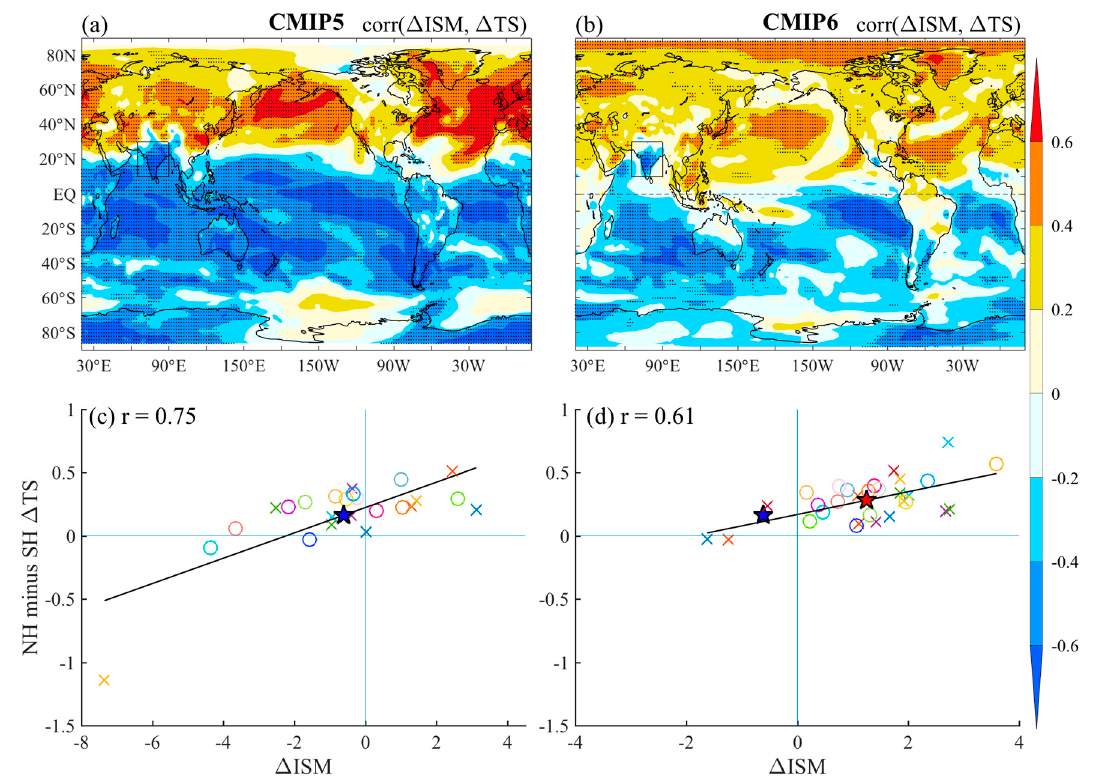
Figure 10. Spatial pattern of intermodel correlation coefficients between area-weighted-mean ISM circulation change ( ∆𝐼𝑆𝑀 ) and surface temperature change ( ∆𝑇𝑆 ) in ( a ) CMIP5 and ( b ) CMIP6. ( c ) and ( d ) are the scatterplots of ∆𝐼𝑆𝑀 and Northern Hemisphere (NH) minus Southern Hemisphere (SH) surface warming contrast among models. The black dots indicate the correlation coefficients significate at 95% confidence level. The blue and red stars, respectively, indicate the CMIP5 and CMIP6 MME results.